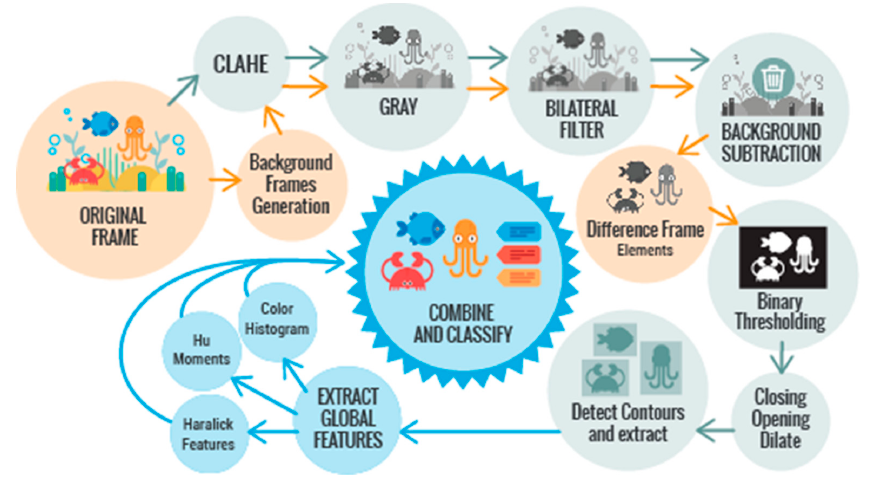
Figure 3. Image processing pipeline.